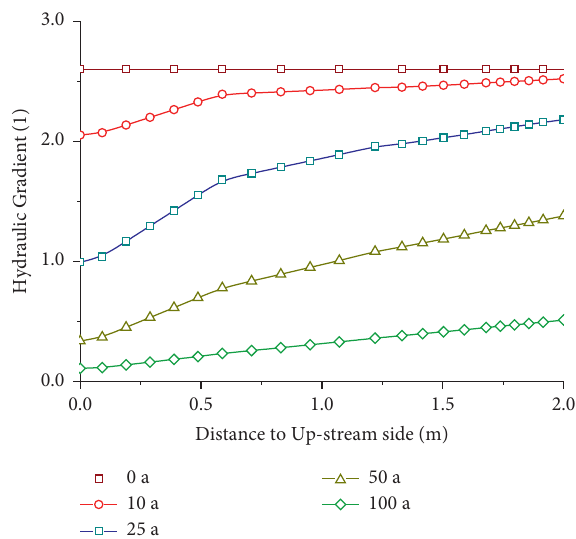
Figure 19: Evolution of the hydraulic gradient in the grout curtain central line at 61.00m.